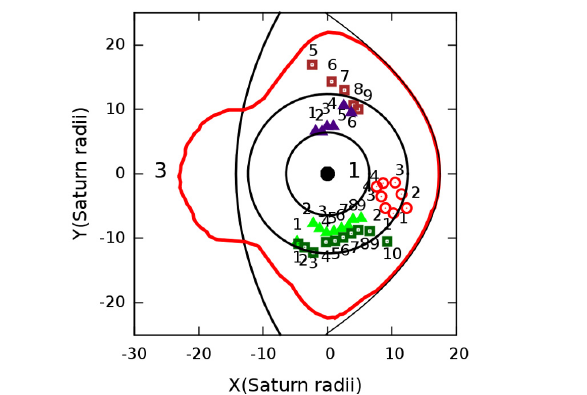
Fig. 11. Southern auroral boundary points for image C mapped into the equatorial plane, in the same format as Fig. 7.